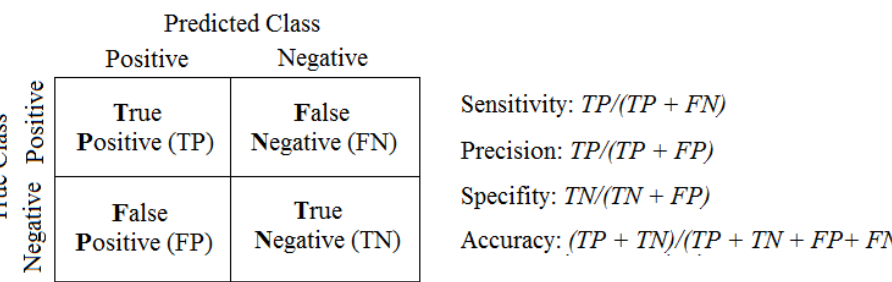
Figure 6. Performance measurements calculated on the basis of the confusion